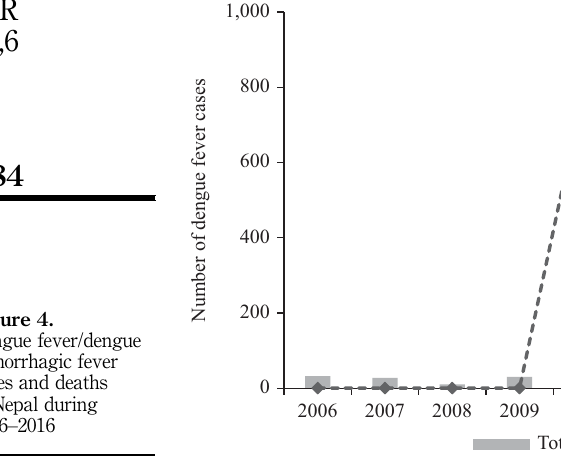
Figure 4. Dengue fever/dengue hemorrhagic fever cases and